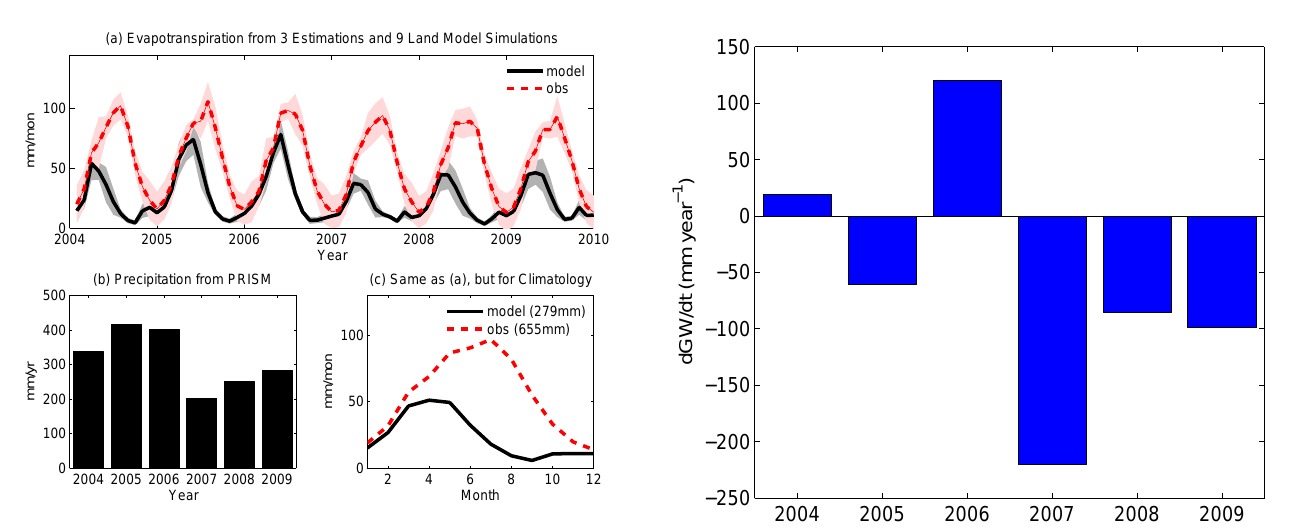
Figure 3. (a) the comparison between the remote-sensing-estimated ET, and nine GLDAS, NLDAS, and CLM models. The lines in- dicate the ensemble mean while the shading indicates uncertainty around the ensemble mean, (b) annual precipitation for the Cen- tral Valley, and (c) monthly climatology for satellite-observed and modeled ET.